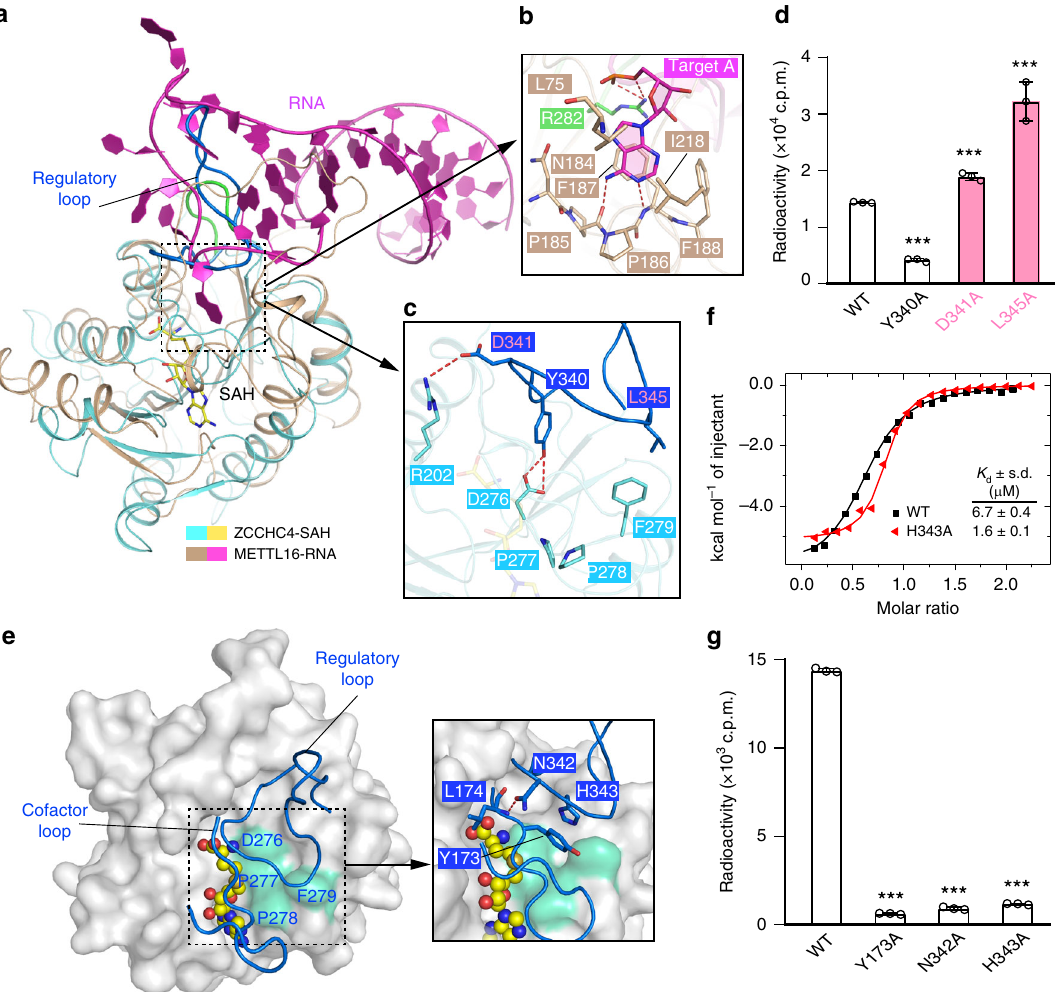
Fig. 2 The regulatory loop controls the enzymatic activity of ZCCHC4. a Structural alignment of ZCCHC4 MTase domain (aquamarine) and HP1 RNA (magenta)-bound METTL16 (wheat) (PDB 6DU4 [https://www.rcsb.org/structure/6DU4]). The regulatory loop and its corresponding region in METTL16 are colored marine and green, respectively. The MTase-associated domains of ZCCHC4 were removed for clarity. b Close-up view of the interaction between METTL16 and the target adenosine. c Close-up view of the interaction between the regulatory loop and catalytic site residues. The hydrogen- bonding interactions are depicted as dashed lines. d Methylation activity of the regulatory loop mutants of ZCCHC4. The two activity-enhancing mutants are colored in hot pink. e Surface view of the ZCCHC4 MTase domain, with the interaction between the regulatory loop and cofactor loop (both colored marine) stabilizing the closed conformation of the SAH-binding pocket. The SAH molecule is shown in sphere representation. The surface of the catalytic motif is colored in green-cyan. f ITC binding curves of SAM over wild-type (WT) or H343A ZCCHC4. The K d values and error estimates were derived from two independent measurements. g Methylation activity of the mutants on the regulatory loop-cofactor loop interface. Statistical analysis used two-tailed Student ’ s t test for the difference from WT: *** p < 0.001. Source data are provided as a Source Data fi